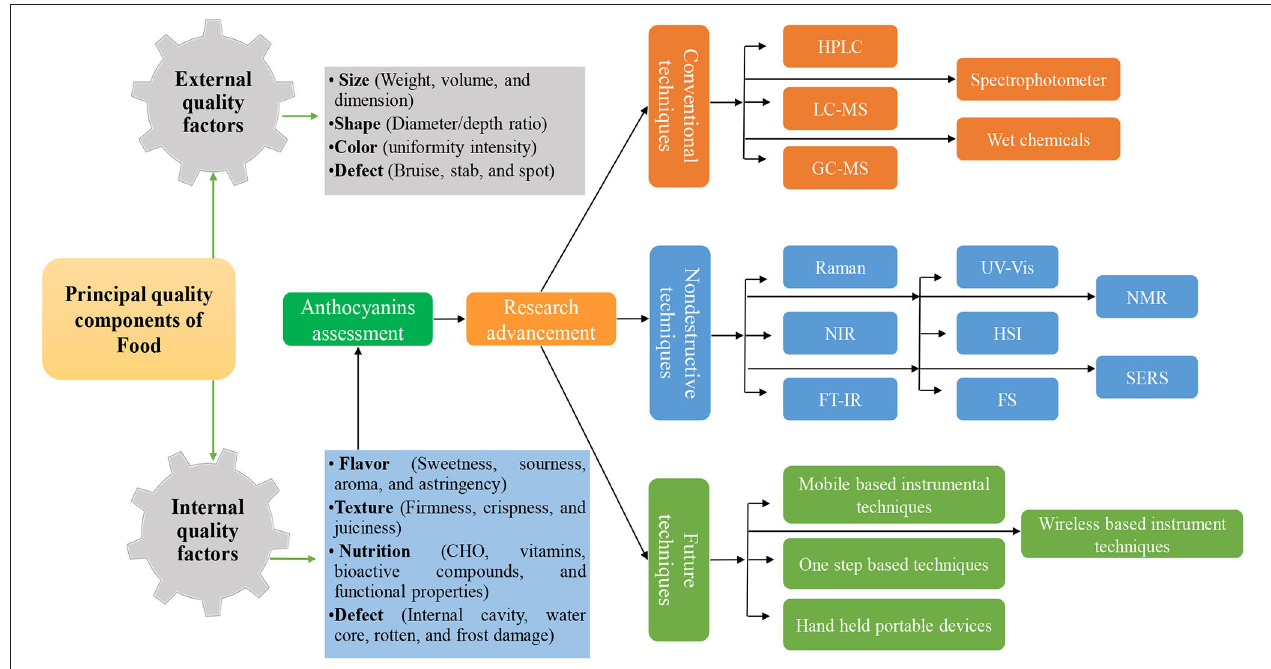
FIGURE 4 | Principal quality components of food and future advancement in non-destructive techniques with